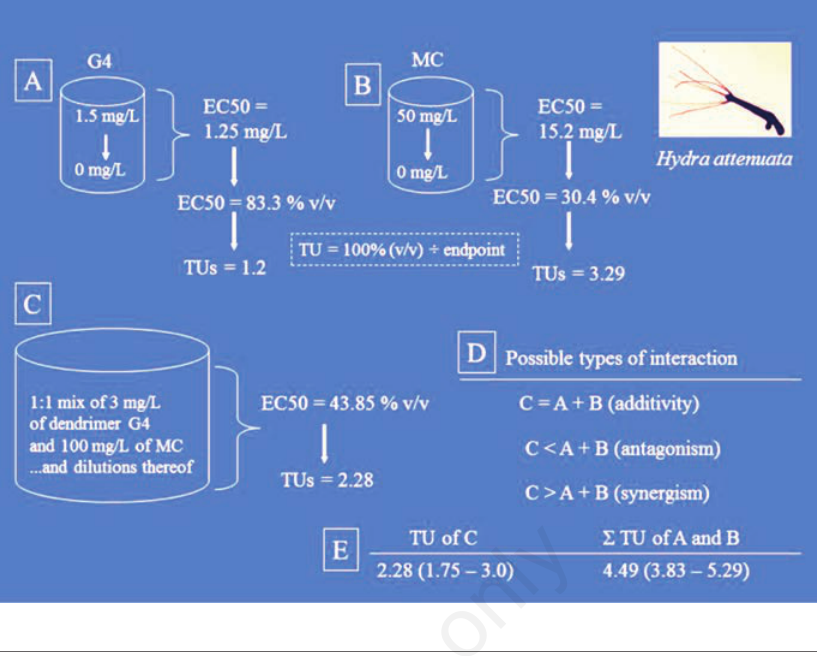
Figure 1. Experimental approach: PAMAM dendrimer G4 and minocycline (MC) inter- active toxicity testing with the Hydra assay (see text for details).